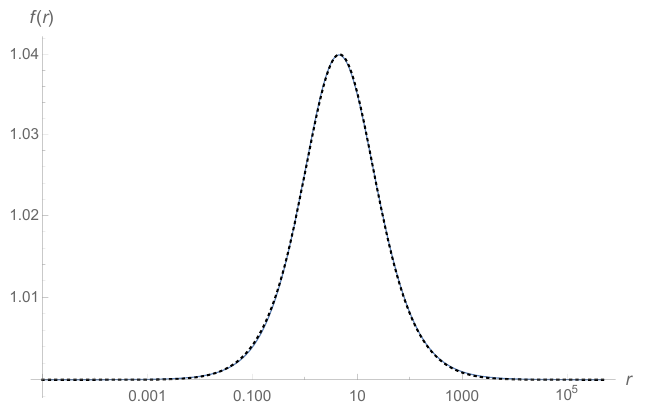
Figure 8 . Log-log plot of the comparison between the numerical solution for f (blue) and the (cid:12)tted f app (dotted) at A = 1.